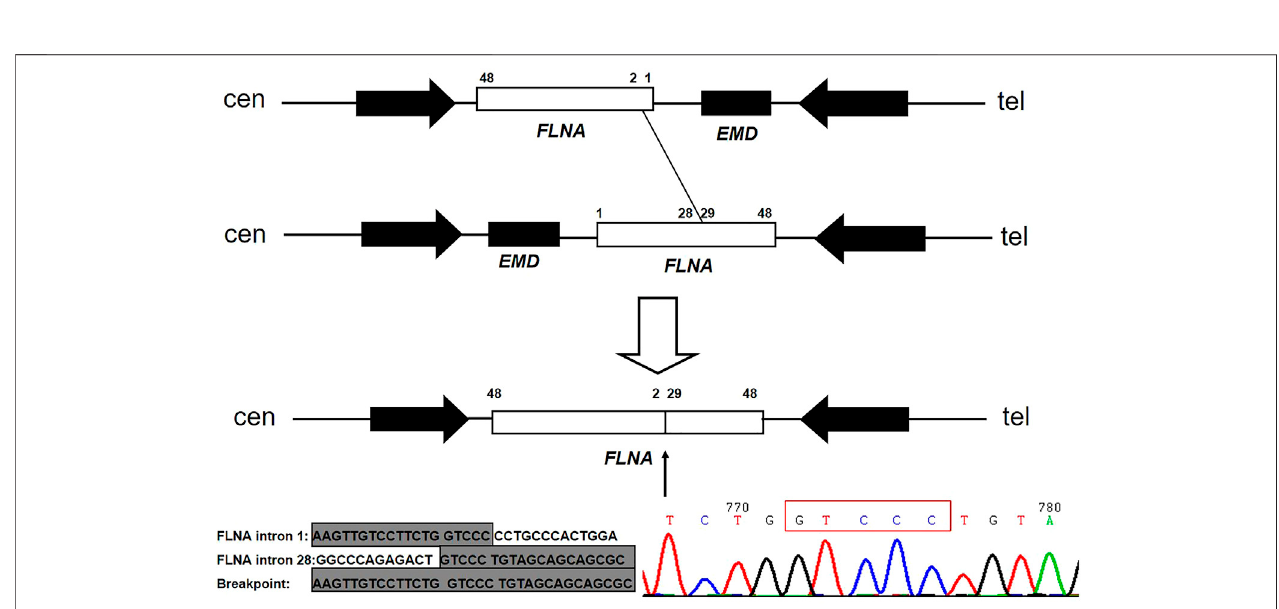
FIGURE 3 | Model of FLNA rearrangement and EMD deletion. The fi rst allele shows the normal FLNA-EMD region. The second allele is a polymorphic inversion containing the entire FLNA-EMD region. The unshaded rectangle represents FLNA , whereas the shaded rectangle represents EMD . Two arrows point to the two large reverted repeats fl anking the FLNA - EMD region. Between homologous X or sister chromatins, 5 bp (GTCCC) overlap between FLNA intron 28 and intron 1 on the background of FLNA - EMD inversion was con fi